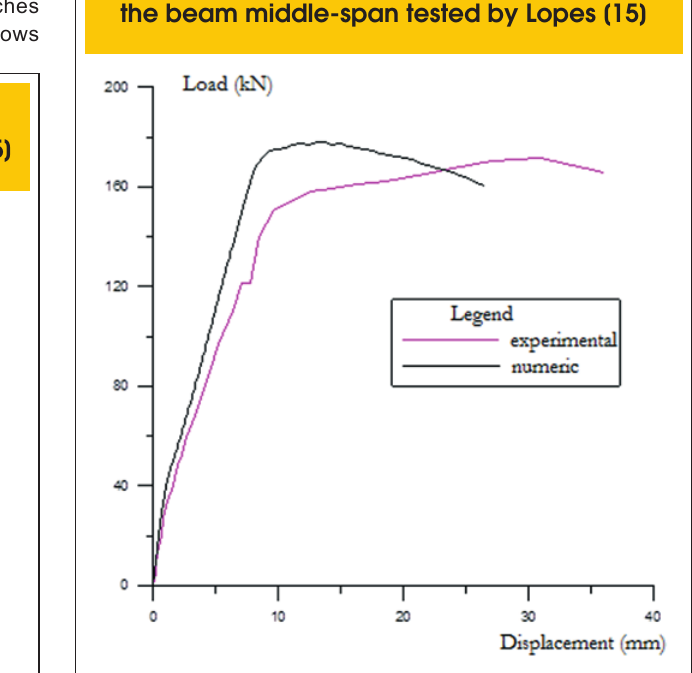
Figure 12 – Chart stress versus displacement of the beam middle-span tested by Lopes